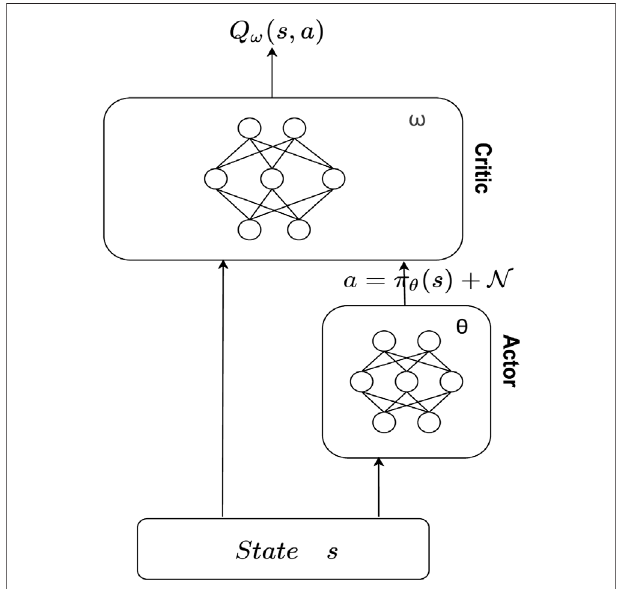
FIGURE 2 | Structure of deep deterministic policy gradient